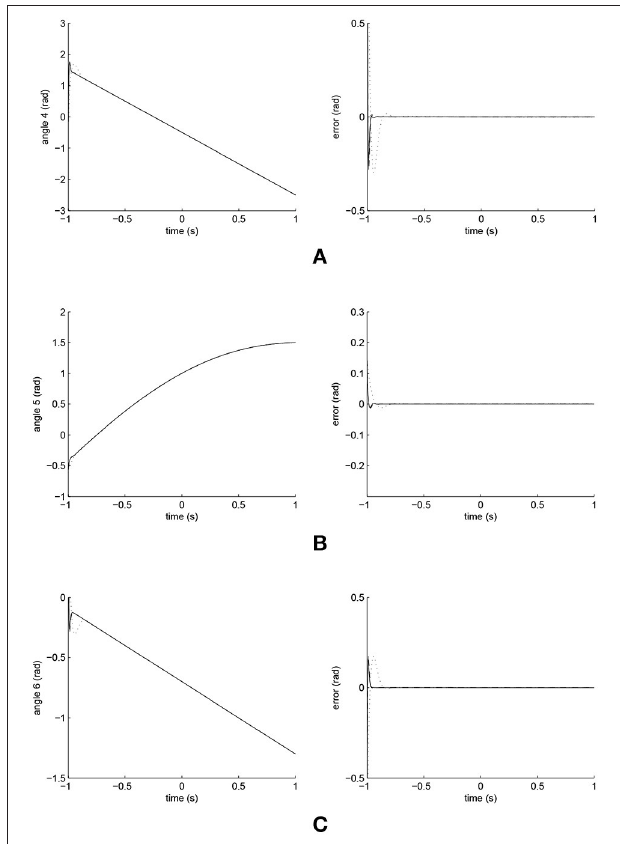
FIGURE 10 | Trajectory responses (in the left) and tracking errors (in the right) of Joints 4, 5, and 6 at ρ 2 = 1. The solid line indicates the performance of the iFBEL; the dotted line represents that of the PID controller; and the dot dash line implies that of the FCMAC controller. (A) Trajectory response and tracking error of Joint 4. (B) Trajectory response and tracking error of Joint 5. (C) Trajectory response and tracking error of Joint